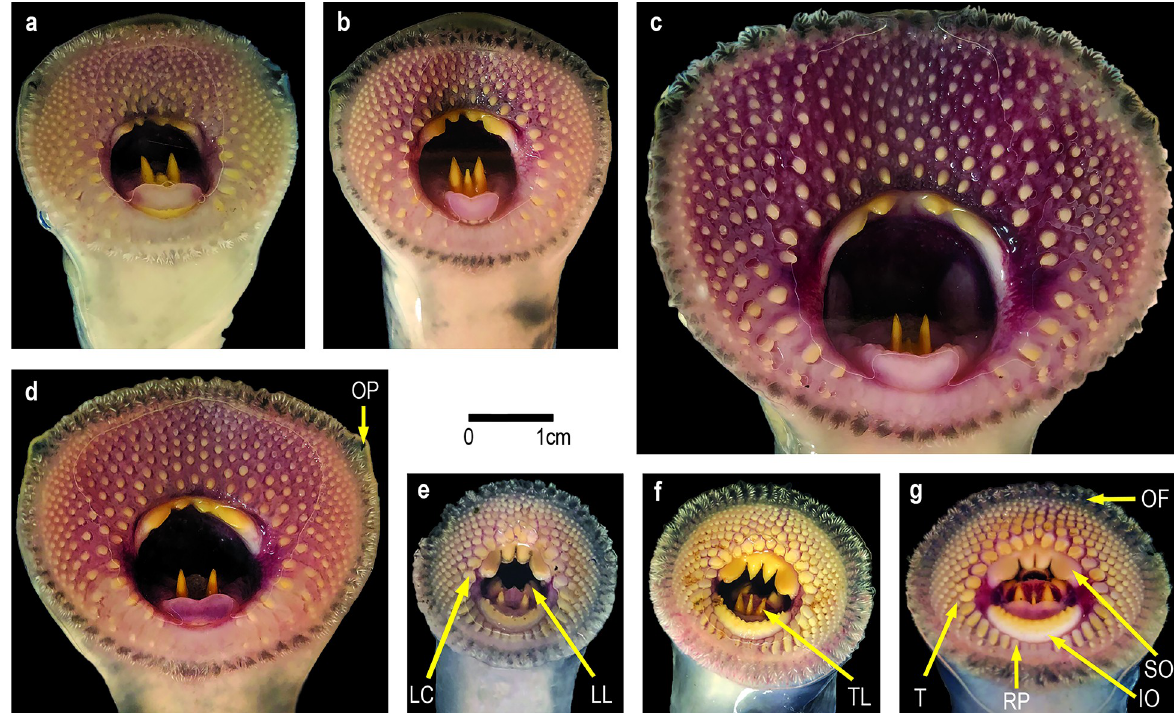
Fig 6. Dentition of immature G . macrostoma (a-d) and G . australis (e-g): IO: infraoral lamina; LC: lateral circumoral; LL: longitudinal lingual lamina; OF: oral fimbria; OP: oral papilla; RP: radial plate; SO: supraoral lamina; T: labial teeth; TL: transverse lingual